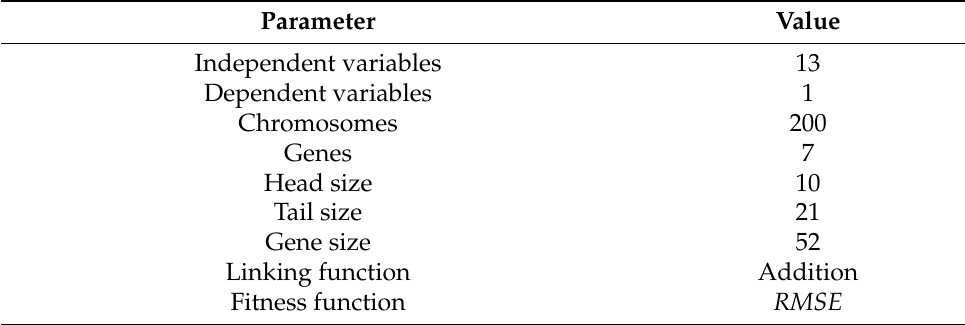
Table 3. Parameter setting for the GEP modeling.